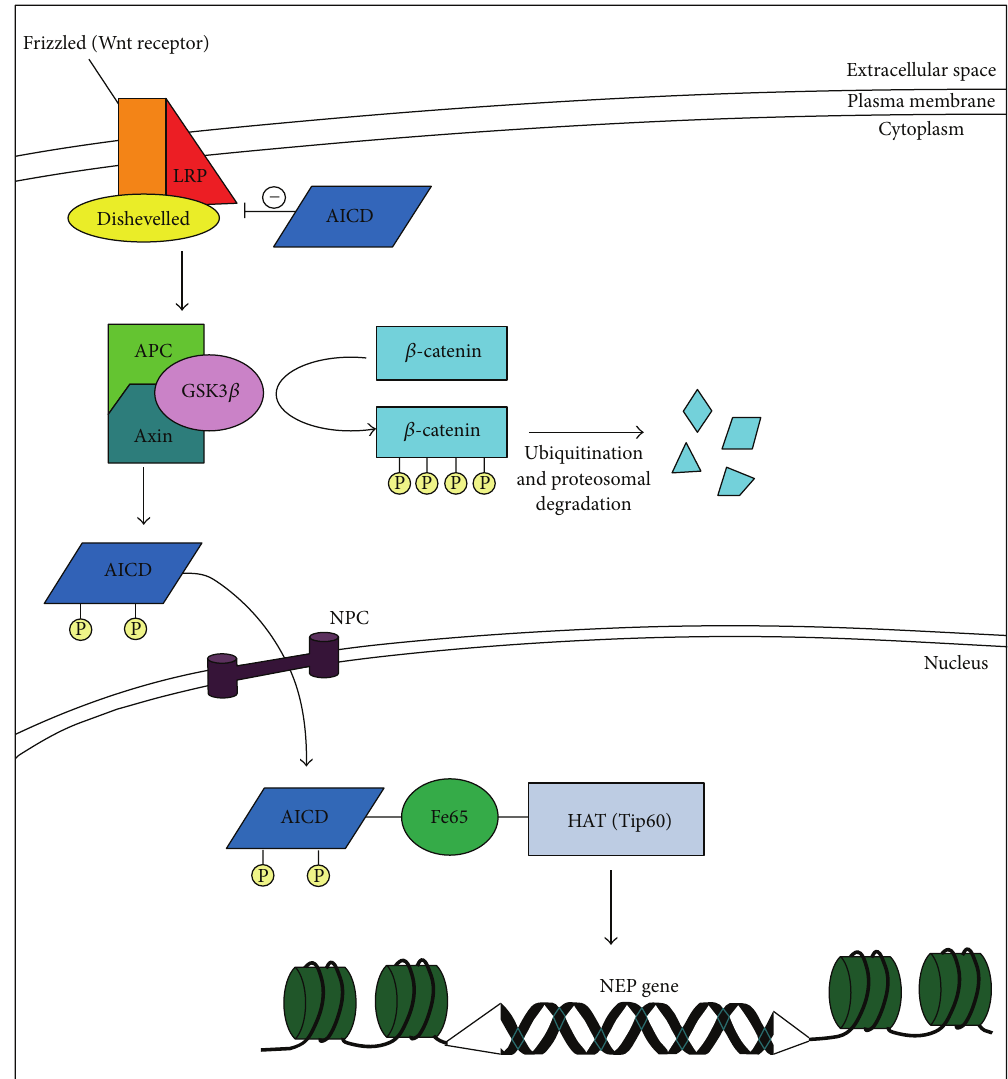
Figure 2: Wnt signaling and its relation to histone-regulated gene expression. In normal circumstances, when Wnt binds to its receptor, Frizzled, it blocks the degradation of cytosolic 𝛽 -catenin, a transcription factor that then accumulates, translocates into the nucleus, and turns on transcription. LRP (low-density lipoprotein receptor-related protein) promotes Wnt-ligand binding to Frizzled. Dishevelled is a cytosolic protein associated with the tail of Frizzled. When AICD (amyloid precursor protein intracellular domain) is present, it inhibits Wnt signaling. The tumor suppressor protein APC (adenomatous polyposis coli) is then bound to the Axin protein, as well as to the kinase GSK3 𝛽 (glycogen synthase kinase 3 𝛽 ), which triggers the phosphorylation of 𝛽 -catenin that, in turn, triggers ubiquitination and degradation of 𝛽 -catenin in the proteasome. The APC-Axin-GSK3 𝛽 complex also phosphorylates AICD which translocates into the nucleus through a NPC (nuclear pore complex). Relevant to Alzheimer’s disease, AICD binds to Fe65 (an A 𝛽 -binding protein) which facilitates its binding to Tip60 (a type of HAT, histone acetyltransferase). This complex can then alter expression of the NEP (neprilysin) gene, which causes neuronal